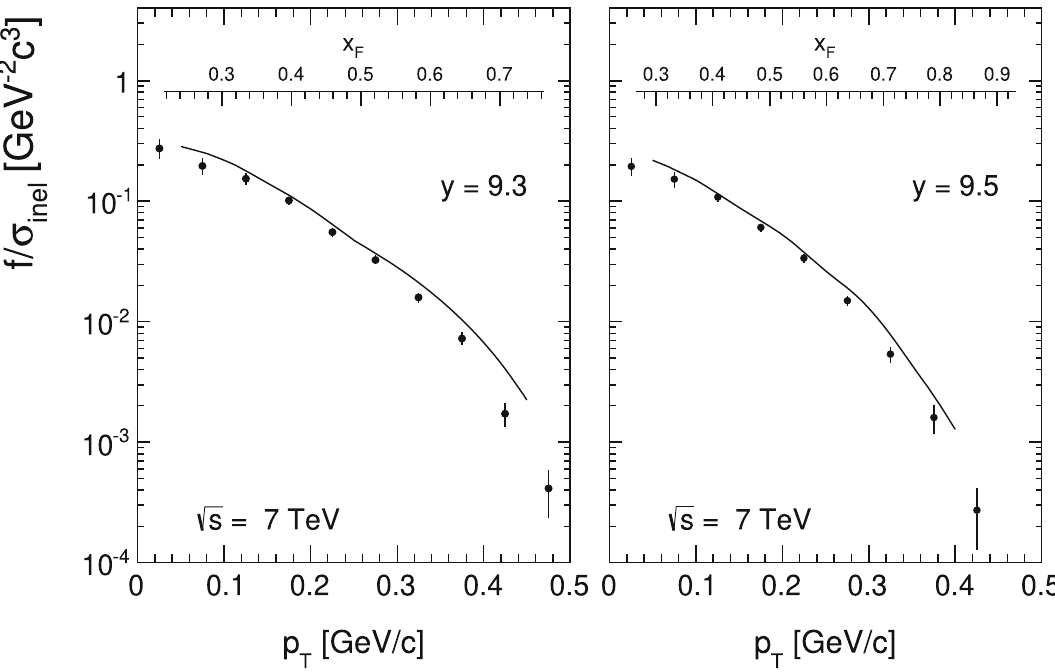
√ s = 7 TeV (data points from LHCf) compared to